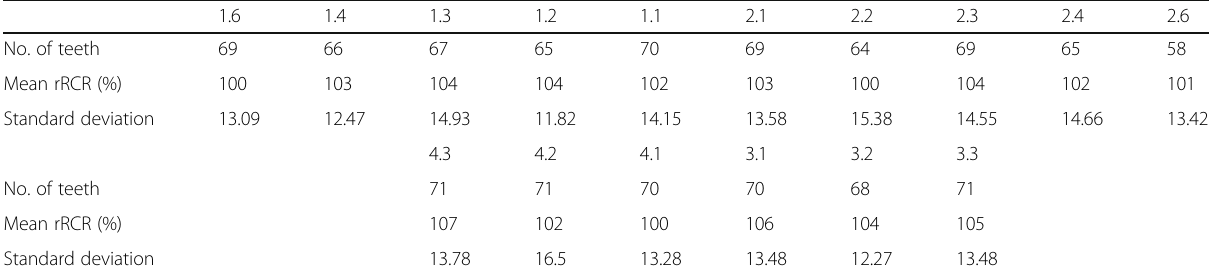
Table 1 Number of measured elements, mean, and standard deviation of RCR for every